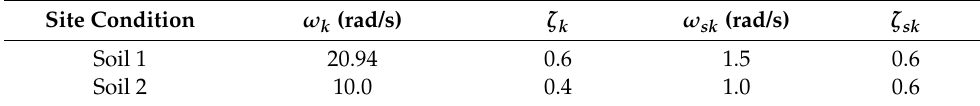
Table 4. Parameters of the Clough–Penzien